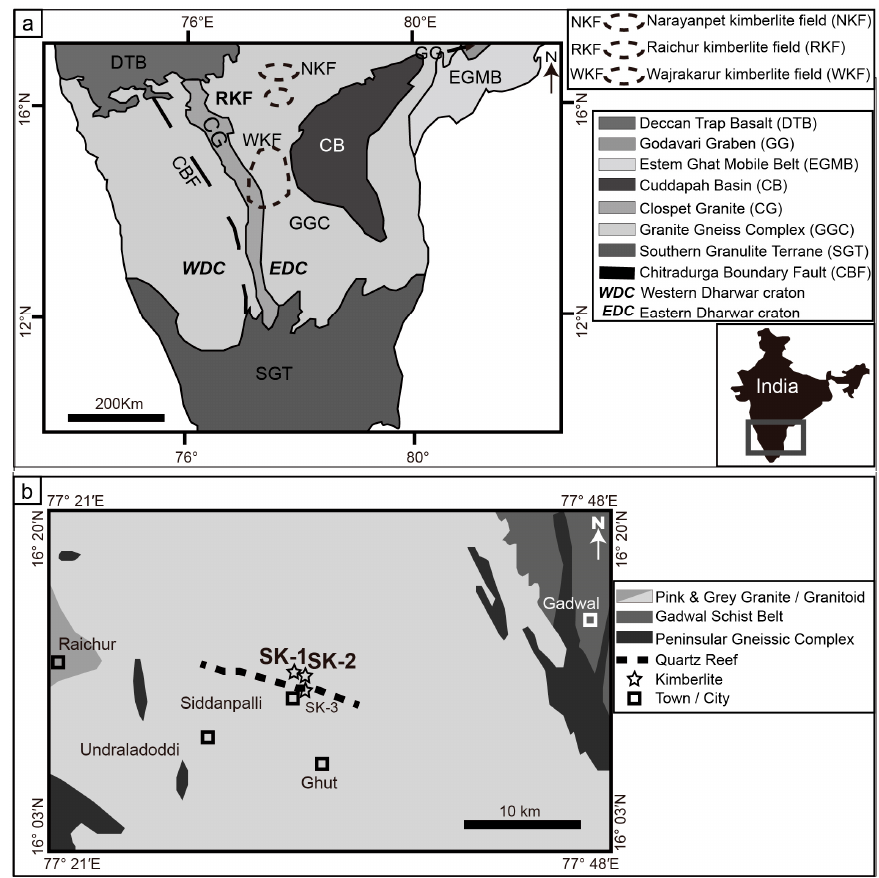
Figure 1. ( a ) Simplified geological map of Southern India showing locations of Narayanpet kimberlite field (NKF), Raichur kimberlite field (RKF) and Wajrakarur kimberlite field (WKF), adapted from Dongre [32]; ( b ) Geological setting of the Siddanpalli kimberlites in the RKF, showing the studied kimberlite samples, adapted from Chalapathi Rao et al. [17].